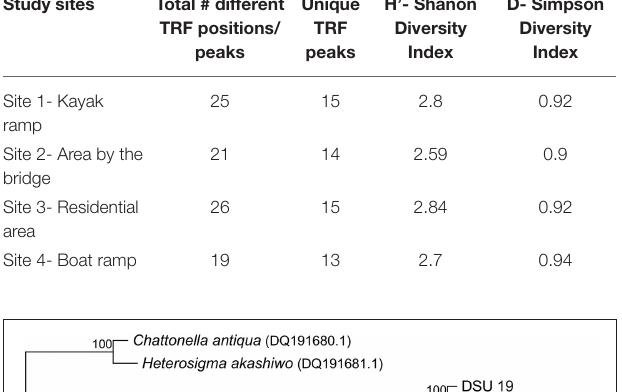
TABLE 3 | Biodiversity indices of the diatom TRF’s obtained from TRFLP analysis.